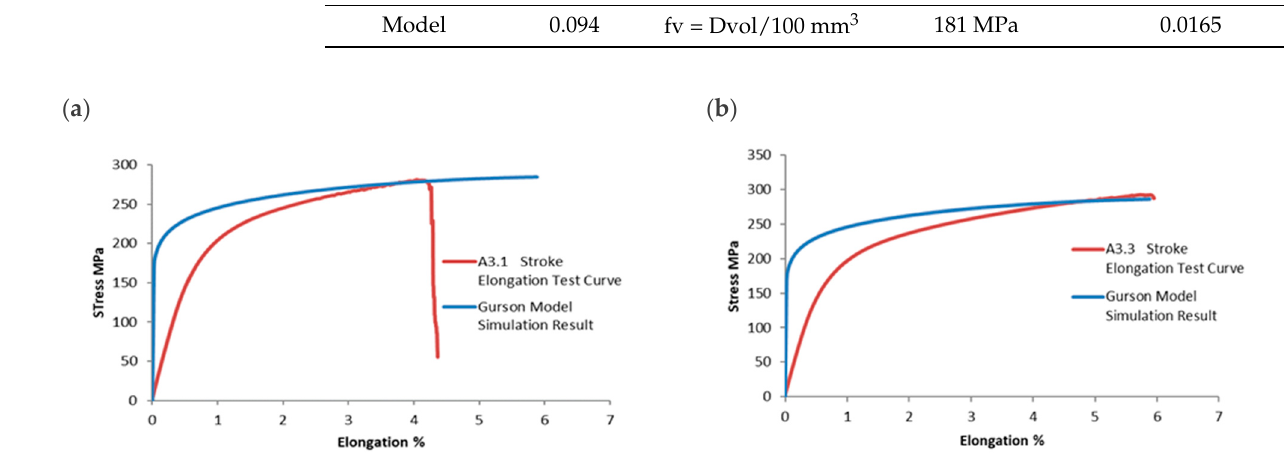
Figure 13. Model Calibration by Tensile Value ( a ) set A3.1 ( b ) set A3.3.